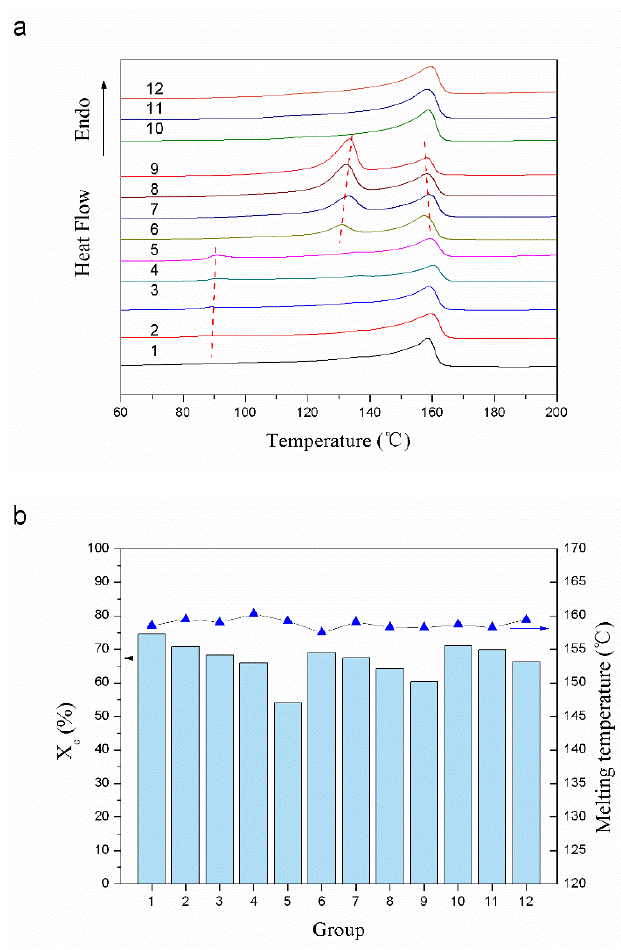
Figure 2. DSC thermograms and results of the samples with di ff erent polymer blends: ( a ) DSC thermograms, ( b ) DSC results.